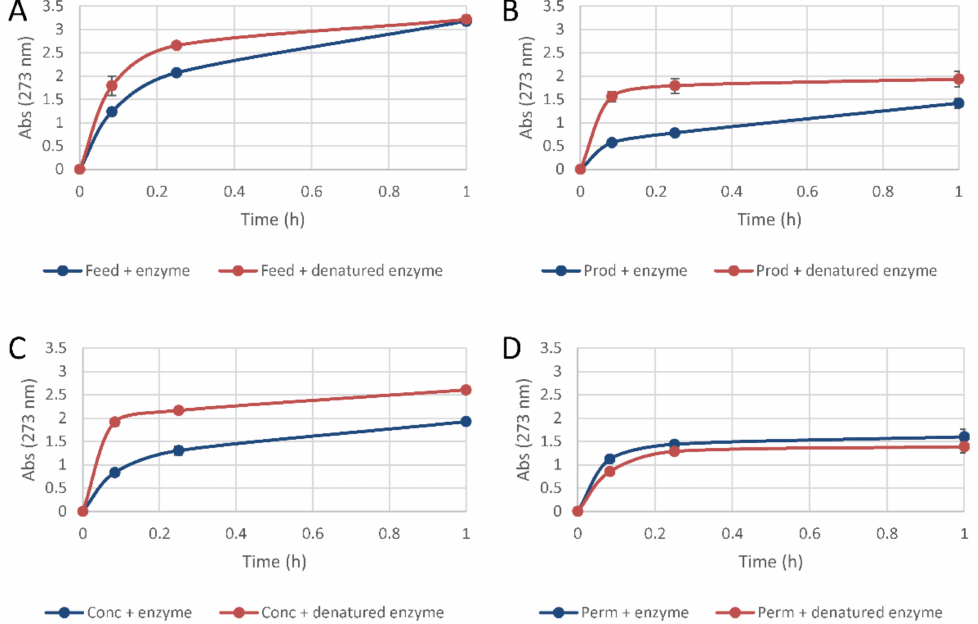
Figure 5. Water stability of films with lignosulfonate preparations [( A ) Feed , ( B ) Prod , ( C ) Conc , ( D ) Perm ] and active (blue symbols) or denatured (red symbols)